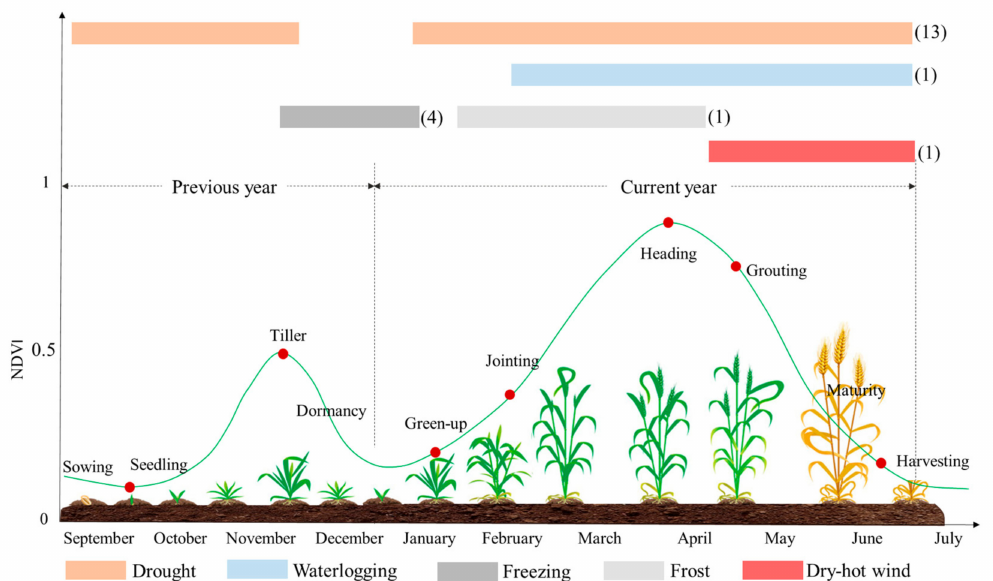
Figure 1. The growth cycle of winter wheat represented by the time series of remotely sensed normalized difference vegetation index (NDVI, green curve) and the relevant hazards that may occur at different crop growth stages. The numbers in parentheses represent the number of relevant published papers in the Web of Science Core Collection for the corresponding